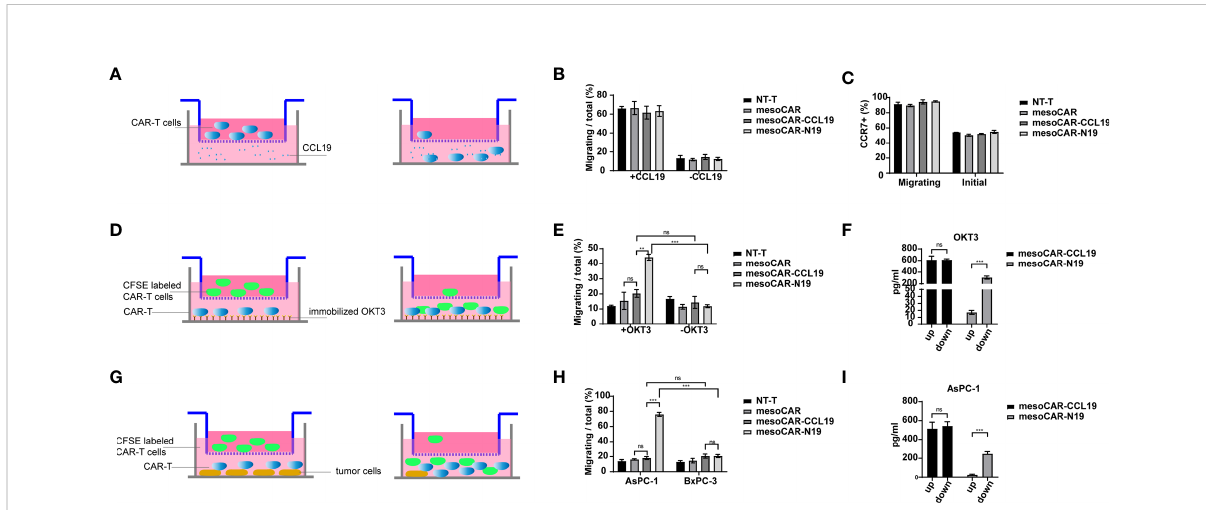
FIGURE 3 Migratory ability of the chimeric antigen receptor T (CAR-T) cells. (A) Schematic diagram of the experimental principle; (B) CAR-T cell migration and quanti fi cation; (C) C-C motif chemokine receptor 7 expression on cells undergoing migration detected by fl ow cytometry; (D) Schematic diagram of the experimental principle; (E) CAR-T cell migration and quanti fi cation; (F) Detection of C-C motif chemokine ligand 19 (CCL19) concentration in the upper and lower chambers by ELISA; (G) Schematic diagram of the experimental principle; (H) CAR-T cell migration and quanti fi cation; (I) Detection of CCL19 concentration in the upper and lower chambers by ELISA. Migration ef fi ciency was calculated as cells undergoing migration/total number of cells in the upper chamber. Error bars represent the mean ± standard deviation (n = 6). **P<0.01; ***P<0.001; ns, no signi fi